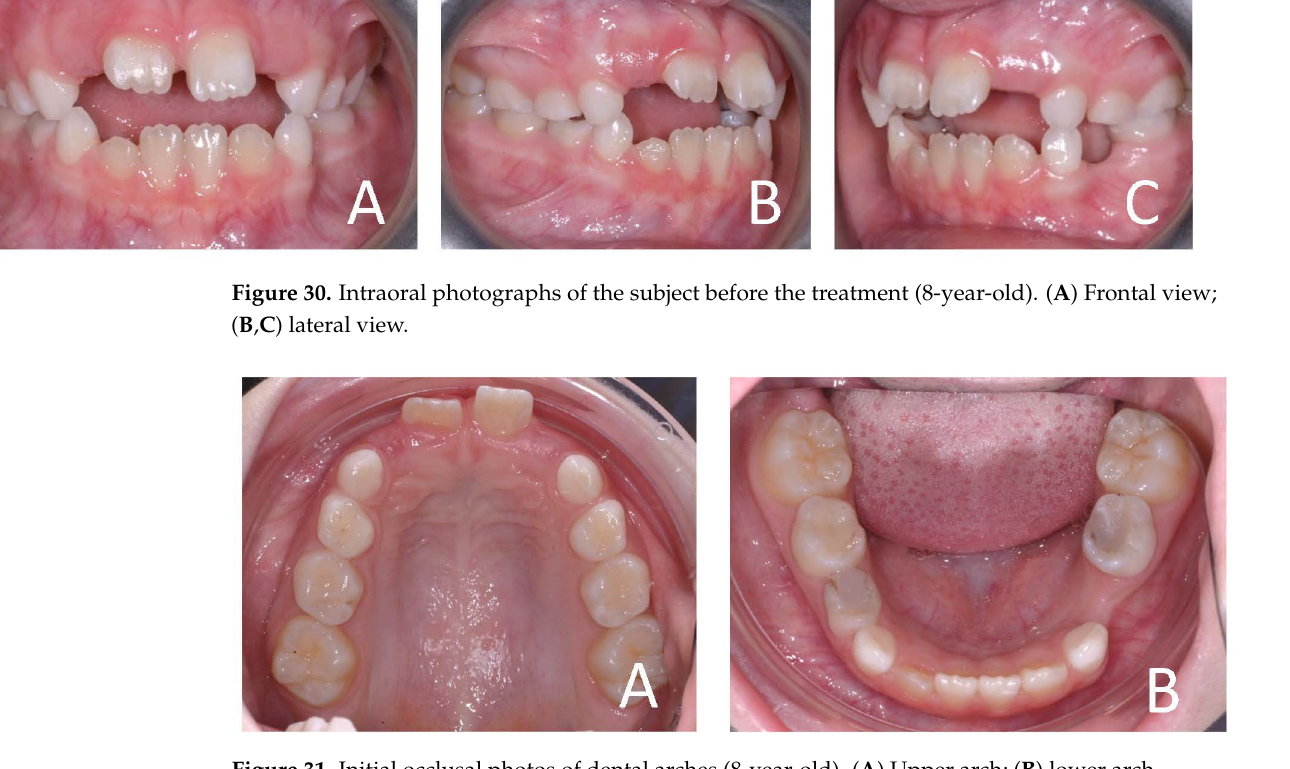
Figure 31. Initial occlusal photos of dental arches (8-year-old) . ( A ) Upper arch; ( B ) lower arch.